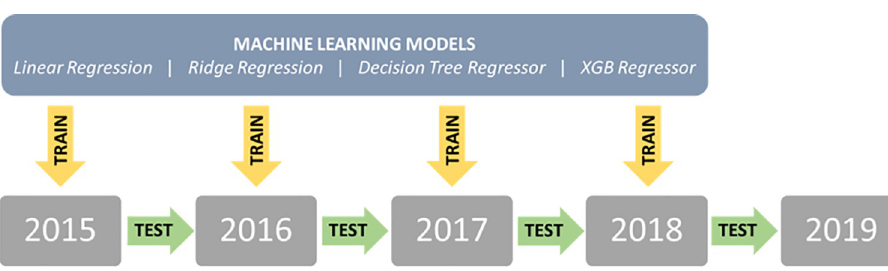
Fig 3. Workflow of the Training and testing procedure of the model for the regional and provincial analyses.